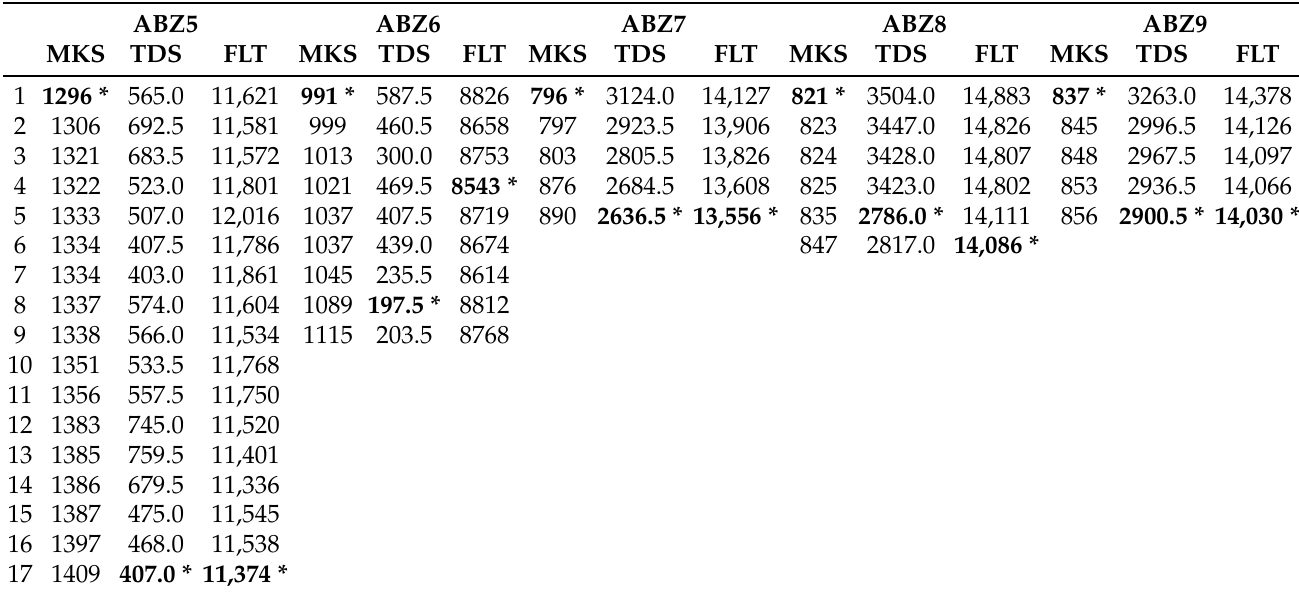
Table A10. Non-dominated front obtained by CMOTA for the JSSP instances proposed by [43].